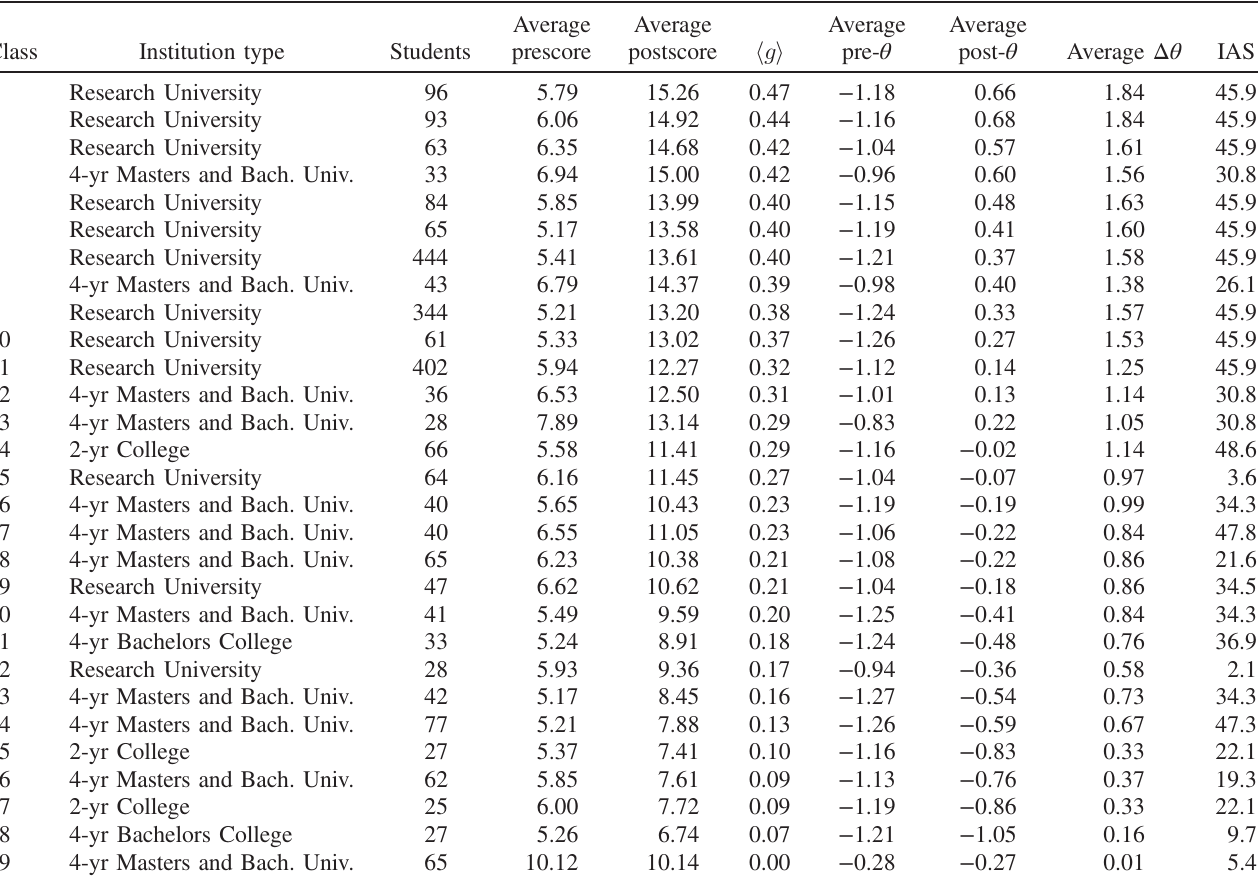
TABLE IV. The institution type, number of enrolled students, average pre- and postinstruction LSCI scores, average normalized gain h g i , average pre- and postinstruction abilities θ , average IRT learning gain Δ θ , and IAS for each class in the national data set with at least 25